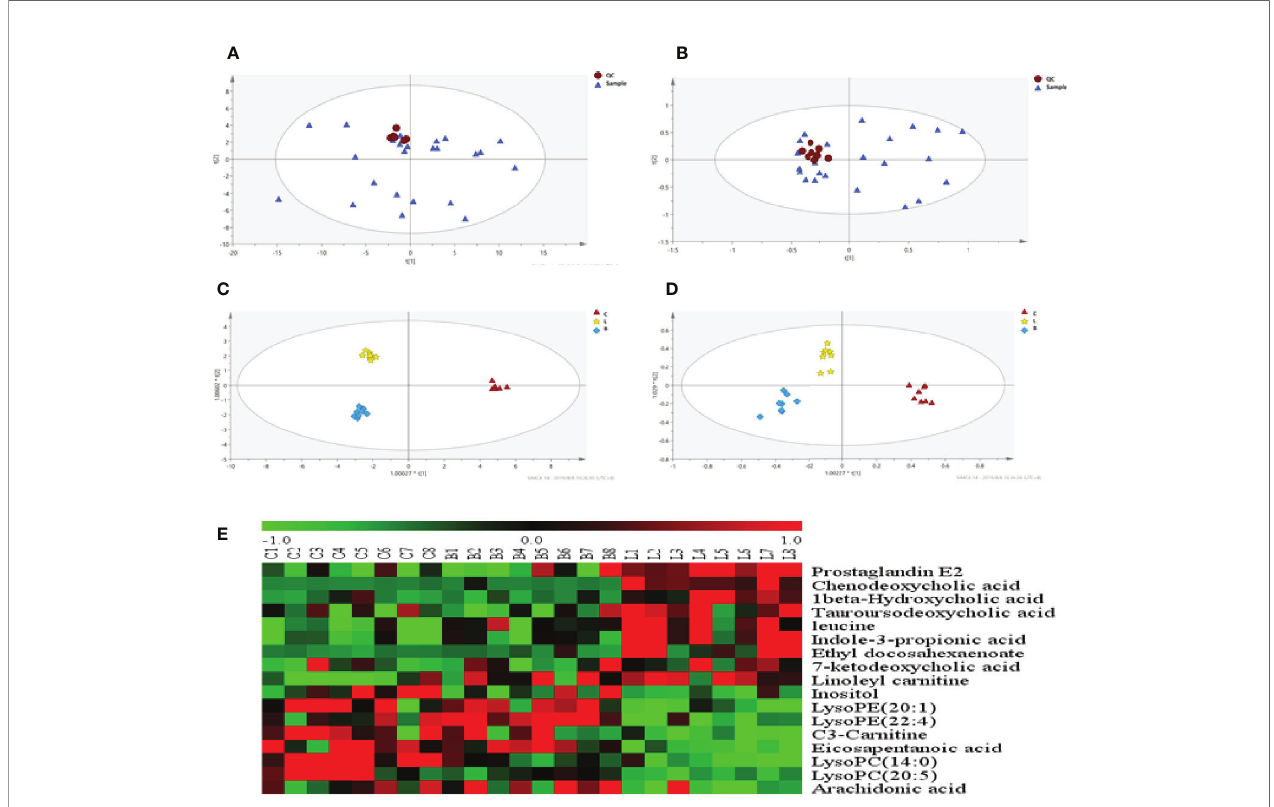
FIGURE 4 | Effect of BZYQD intervention on serum metabolic pro fi ling in loperamide-treated rats. (A, B) PCA score plot in three groups, R 2 X = 0.513, Q 2 = 0.41 in positive model. R 2 X = 0.567, Q 2 = 0.279 in negative model. (C, D) OPLS-DA score plot in three groups, R 2 X = 0.788, R 2 Y = 0.995, Q 2 = 0.515 in positive model. R 2 X = 0.544, R 2 Y = 0.918, Q 2 = 0.487 in negative model. (E) Hierarchical clustering heat map of the differential metabolite levels in control (C), loperamide (L), and loperamide + BZYQD groups (B) (n = 8). The heat map indicated that the serum levels of nine metabolites (Green color) were decreased, and eight metabolites (Red color) were increased in loperamide + BZYQD group as compared with loperamide